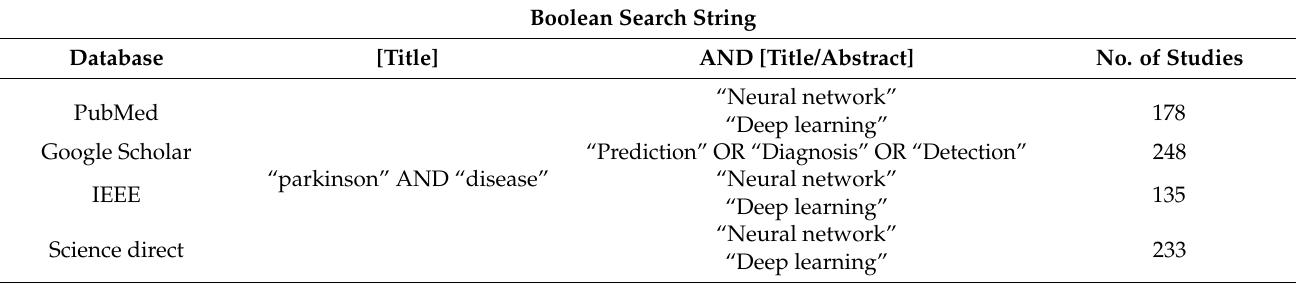
Table 1. Summary of the Boolean search string across the respective journal article